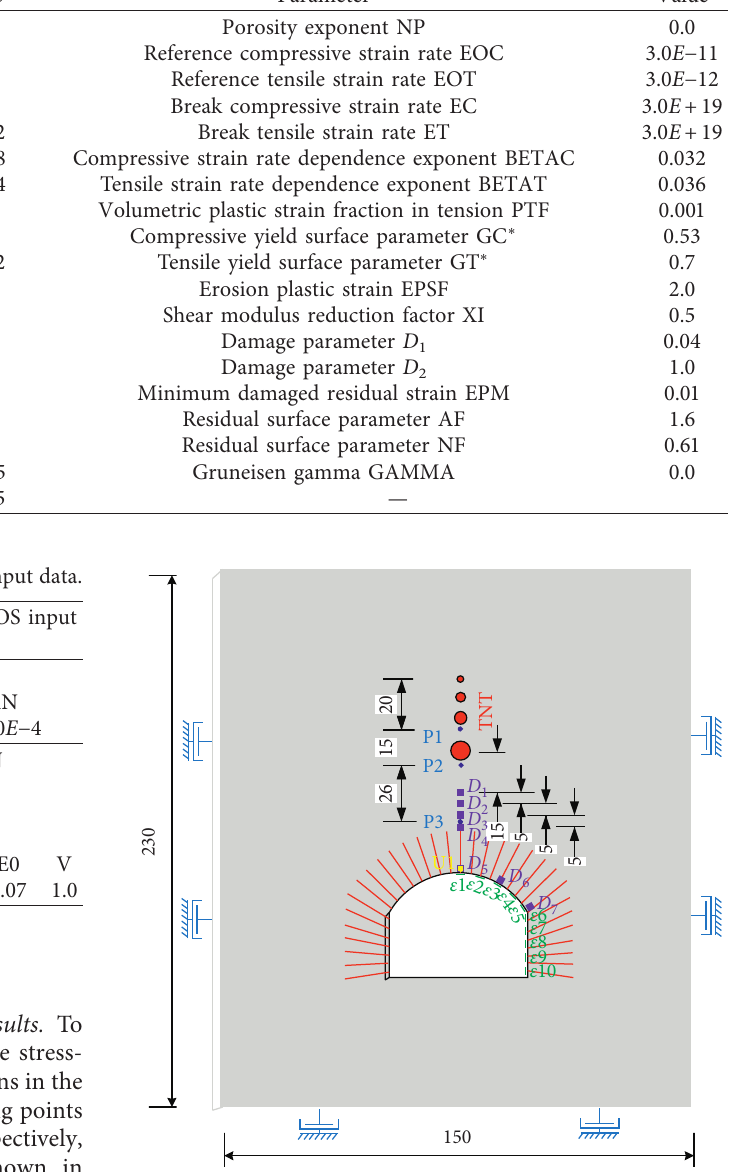
Figure 4: Arrangement of measuring points (unit: